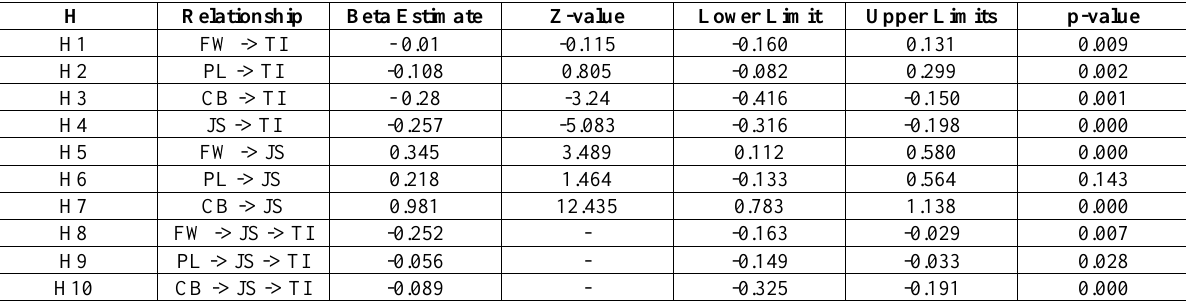
Table 5. Structural Model Assessment Summary